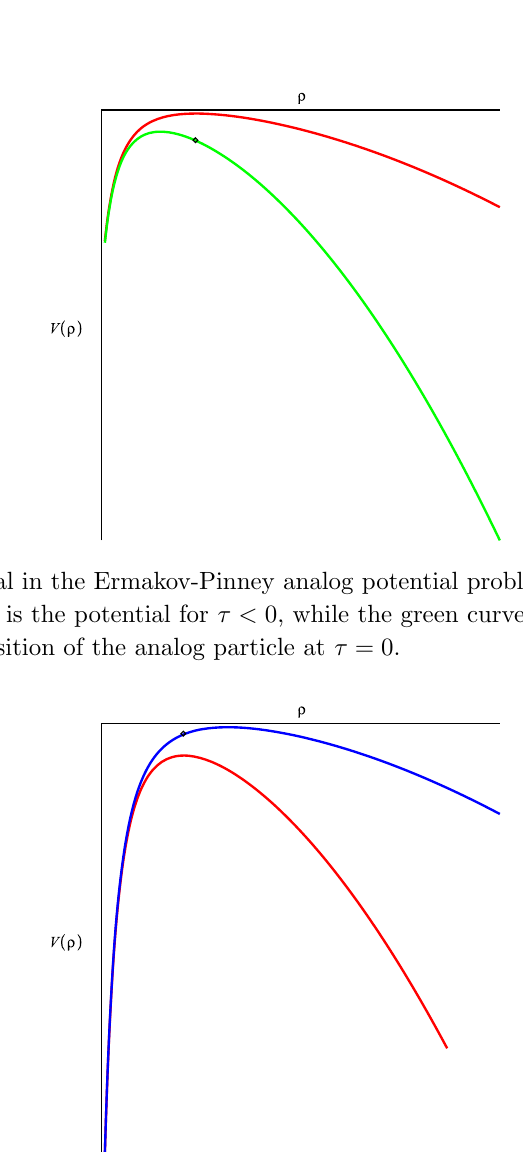
Figure 3. The potential in the Ermakov-Pinney analog potential problem for abrupt quench for ! 0 > ! 1 . The red curve is the potential for (cid:28) < 0, while the green curve is the potential for (cid:28) > 0. The black dot is the position of the analog particle at (cid:28) =